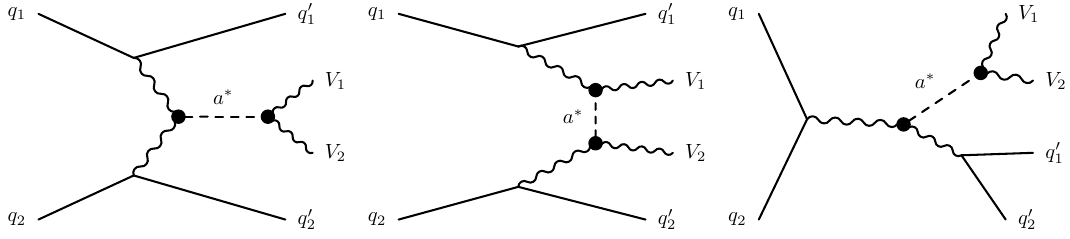
3 Figure 1 . Feynman diagrams for ALP contributions to a generic process q 0 q 0 V 1 V 2 . Fermion 1 q 2 → q 1 2